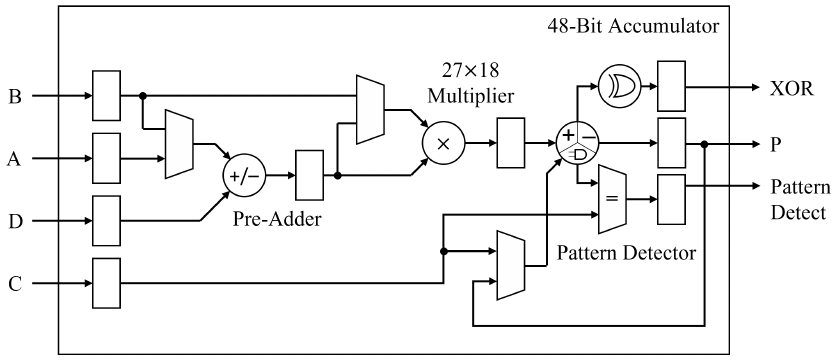
Figure 6. Xilinx FPGA DSP48E2 block [30].